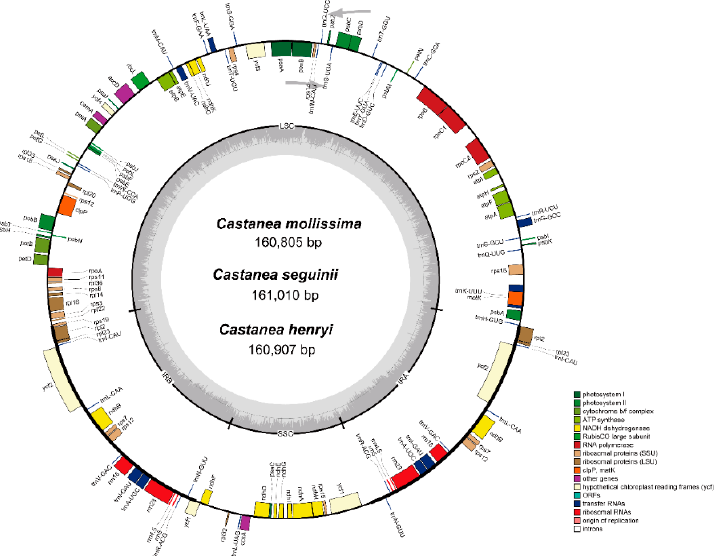
Figure 1. Gene map of the complete cp genome of Castanea . The grey arrows indicate the direction of transcription of the two DNA strands. A GC-content graph is depicted within the inner circle. The circle inside the GC content graph marks the 50% threshold. The maps were created using Organellar Genome DRAW